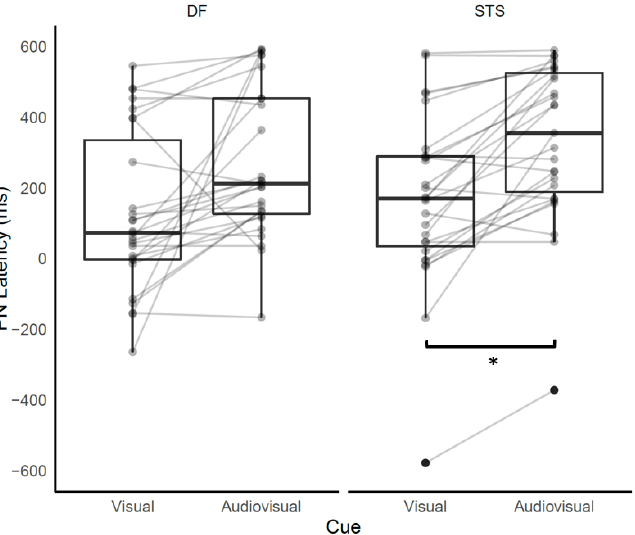
Figure 3. Box and whisker plots showing comparison of CNV PN latency with visual versus audio- visual cues during ankle dorsiflexion (DF) and sit-to-stand (STS) movements. Individual datapoints are linked with light grey lines. * represents statistically significant differences ( p < 0.05).